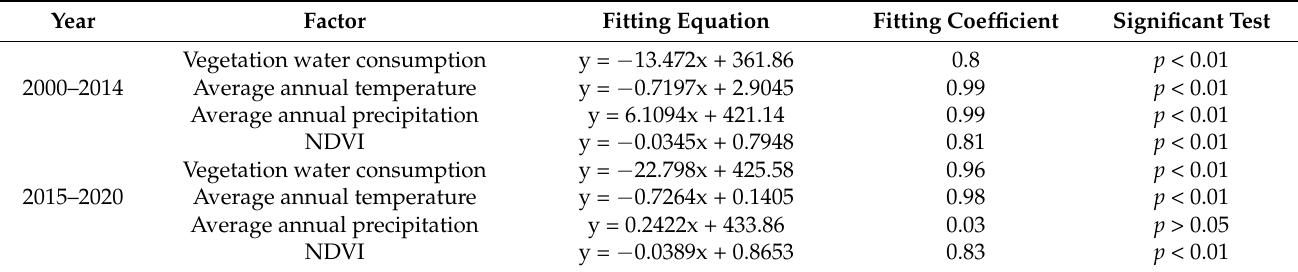
Table 1. Linear relationships between the VWC, annual average temperature, precipitation, NDVI, and altitude